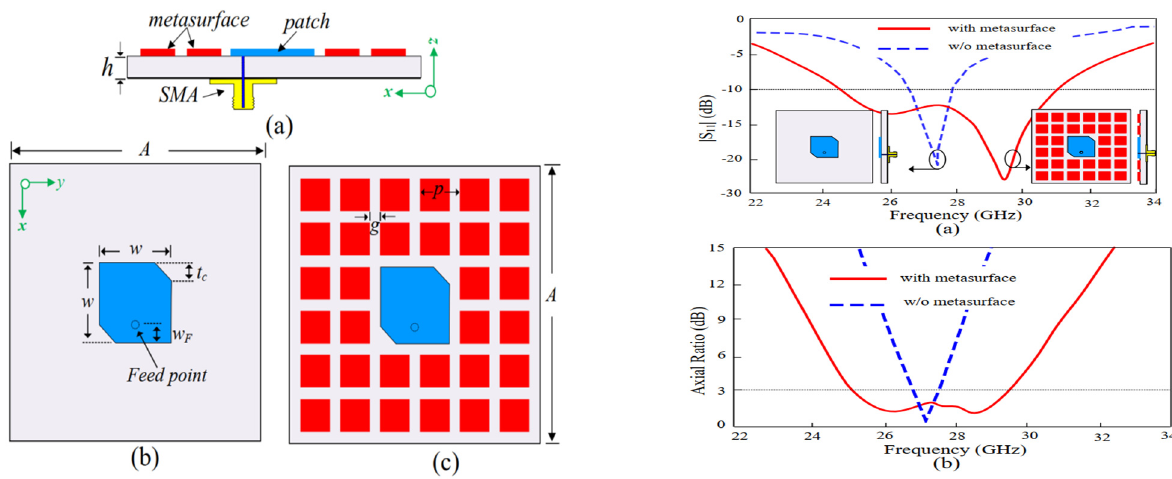
Figure 15. Antenna geometry: ( a , left ) side view ( b , c , left ) top and bottom view, and ( a , b ) ( right ) impact of MS on S 11 and axial ratio [61].